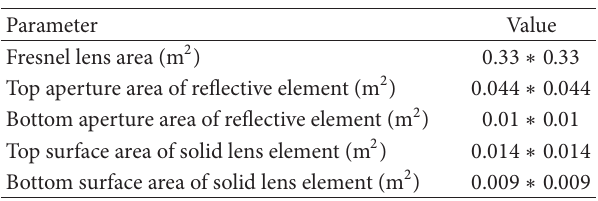
Table 1: Size parameters of the Fresnel solar concentrator with the hybrid SOE.